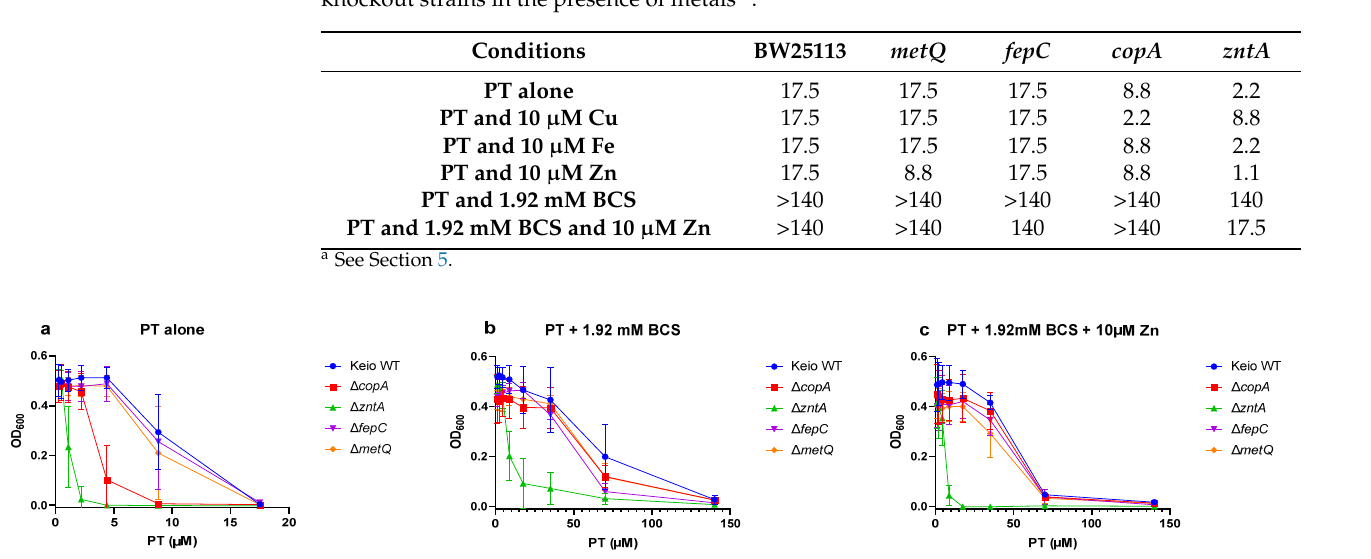
Figure 6. Growth under incremental concentrations of pyrithione (PT). Growth (OD 600 ) of E. coli K-12 BW25113 (Keio WT) and the Keio knockout strains ∆ copA , ∆ zntA , ∆ fepC , and ∆ metQ , compared across the relevant concentrations of PT alone ( a ), or in combination with 1.92 mM BCS ( b ), or in combination with 1.92 mM BCS and 10 µM ZnCl 2 ( c ). Table 3. Minimum inhibitory concentrations (MICs) of pyrithione (PT) against E. coli BW25113 and knockout strains in the presence of metals a .